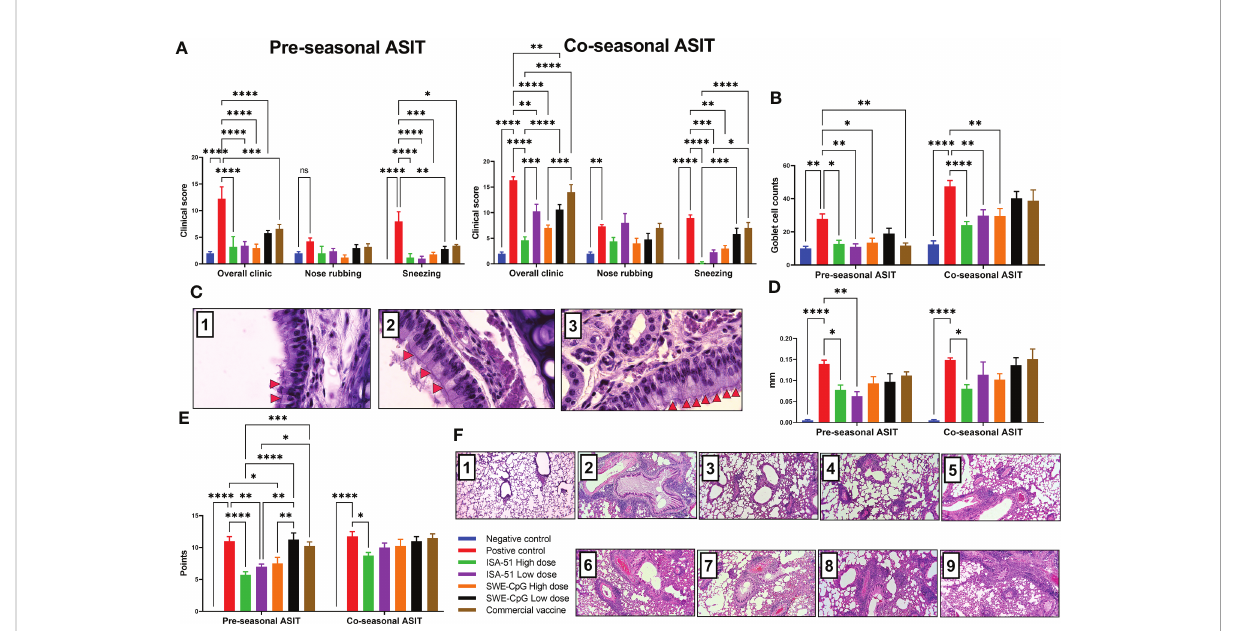
FIGURE 5 Therapy for Artemisia vulgaris -induced allergic rhinitis (A – C) and bronchial asthma (D – F) in pre- and co-seasonal ASIT regimen with different vaccine formulations. Allergic rhinitis in mice after challenge with Artemisia vulgaris pollen was evaluated by the intensity of such clinical signs as sneezing, nasal rubbing, and their combination (A) , and the number of Goblet cells in nasal mucosal epithelium by histological analysis (B) . (C) - histology of mouse nasal turbinates (Hematoxylin-Eosin staining; x1000): 1. Negative control, 2. ASIT group, 3. Positive controls. Red arrows indicate hyperplasia of the Goblet cells. The effectiveness of bronchial asthma therapy after ASIT was based on the results of the ear swelling test (D) and the level of lung pathological changes of mice (E) after challenge. The results of the ear swelling test are presented as the delta in the thickness of mouse auricles with the allergen or PBS, which was expressed in mm. Lung histological analysis after challenge was performed on a 16-point score (non-Type 2 in fl ammation). (F) - overview lung pictures of mice in different groups, x100 magni fi cation: 1. Negative control; 2, 6. Positive controls in the pre- and co-seasonal ASIT regimens, respectively; 3, 7. ISA-51 groups in pre- and co-seasonal ASIT regimens, respectively; 4, 8. SWE-CpG groups in pre- and co-seasonal ASIT, respectively; 5, 9. Commercial vaccine group in pre- and co-seasonal ASIT regimens, respectively; Differences in the studied parameters between animal groups were assessed using Tukey ’ s multiple comparisons test. NS - not signi fi cant. A P<0.05 value was considered a signi fi cant difference. *P <0.05, **P <0.01, ***P <0.001, and ****P